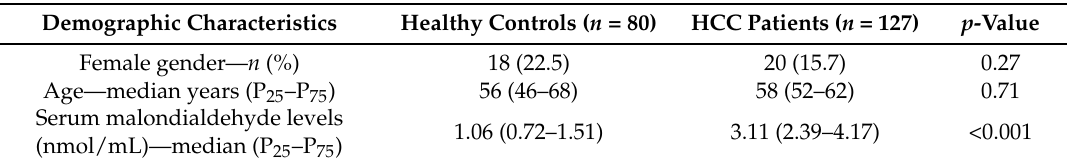
Figure 1. Serum malondialdehyde (MDA) levels in healthy controls, and in 1-year survivors and non-survivors undergoing liver transplantation for hepatocellular carcinoma. P 25 –P 75 are percentile 25 and 75. Table 1. Demographic characteristics of healthy controls and patients with hepatocellular carcinoma (HCC) undergoing liver transplantation.